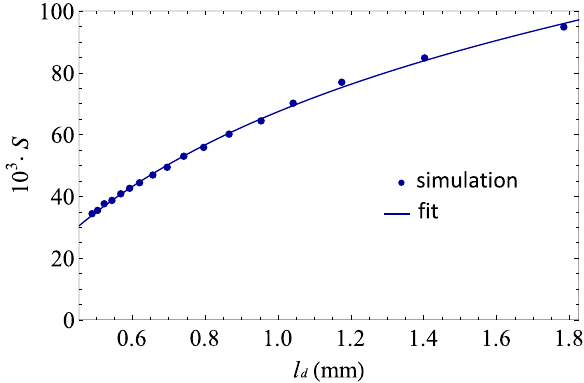
Fig. 3 Dependence of the ratio f ( E L )/ f ( E R 0 ) on the dechanneling length in 1mm silicon crystal